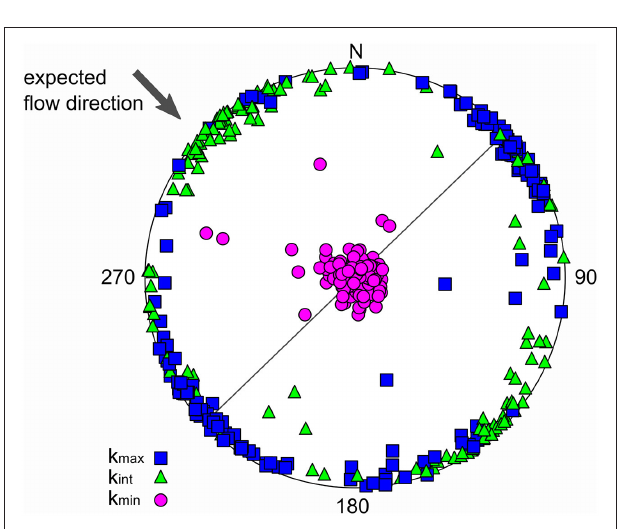
FIGURE 8 | Anisotropy of susceptibility principle axes (tilt-corrected coordinates): minimum principle axes (k min , circles) group perpendicular to the bedding plane, maximum principle axes (k max , squares) group in the strike direction (gray line) of the bedding